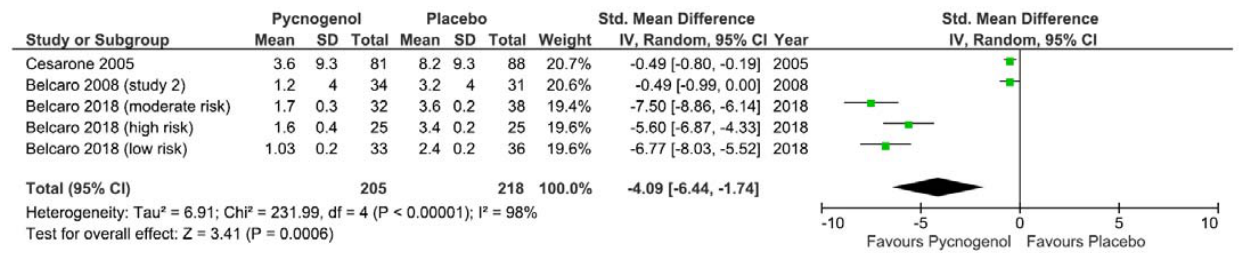
Figure 4. Forest plot of Cohen d effect size (standard mean difference) of studies examining the effect of Pycnogenol on participant edema following commercial air flights using a random effects model. Diamond represents overall effect size, squares indicate percentage weighting of each study to overall effect size and 95% confidence intervals shown using horizontal lines.